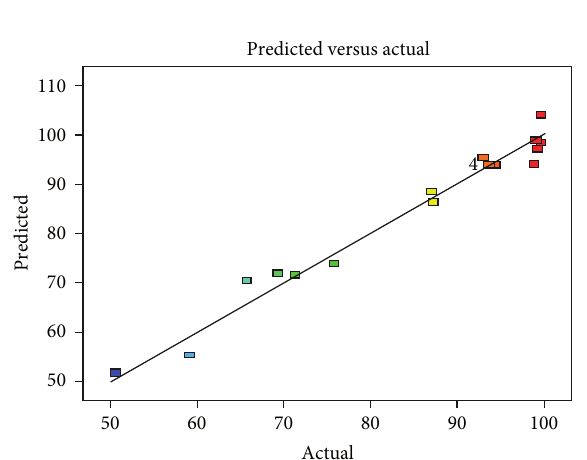
F 2: e actual and predicted plot for adsorption capacity of Cr(VI) ions using